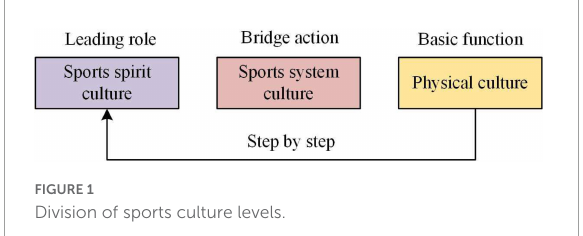
FIGURE1 Division of sports culture